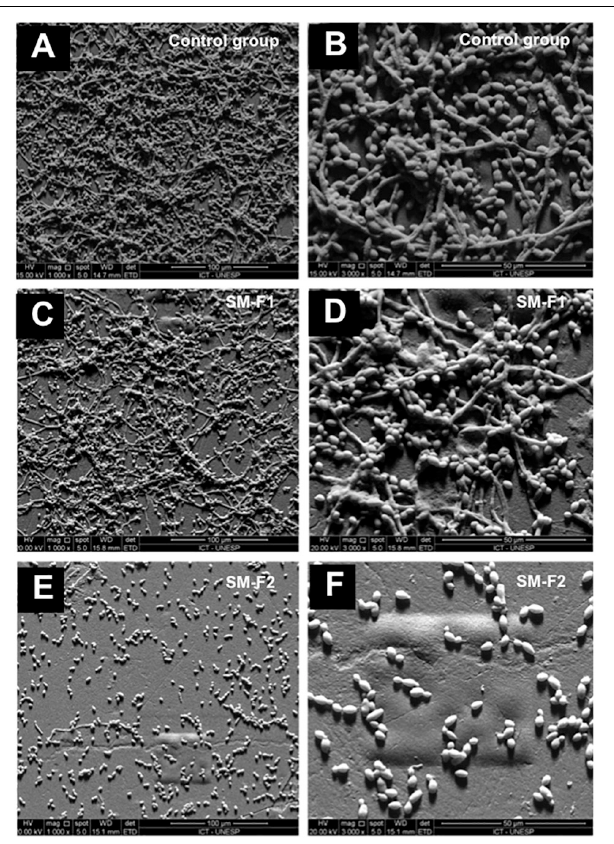
FIGURE 3 | SEM of fungal filamentation. Presence of C. albicans yeast and hyphae was assessed within the following groups: non-treated control at 1000 × magnification (A) and 3000 × magnification (B) , cells treated with 10 mg/mL SM-F1 at 1000 × magnification (C) and 3000 × magnification (D) , and cells treated with 10 mg/mL SM-F2 at 1000 × magnifications (E) and 3000 × magnification (F)